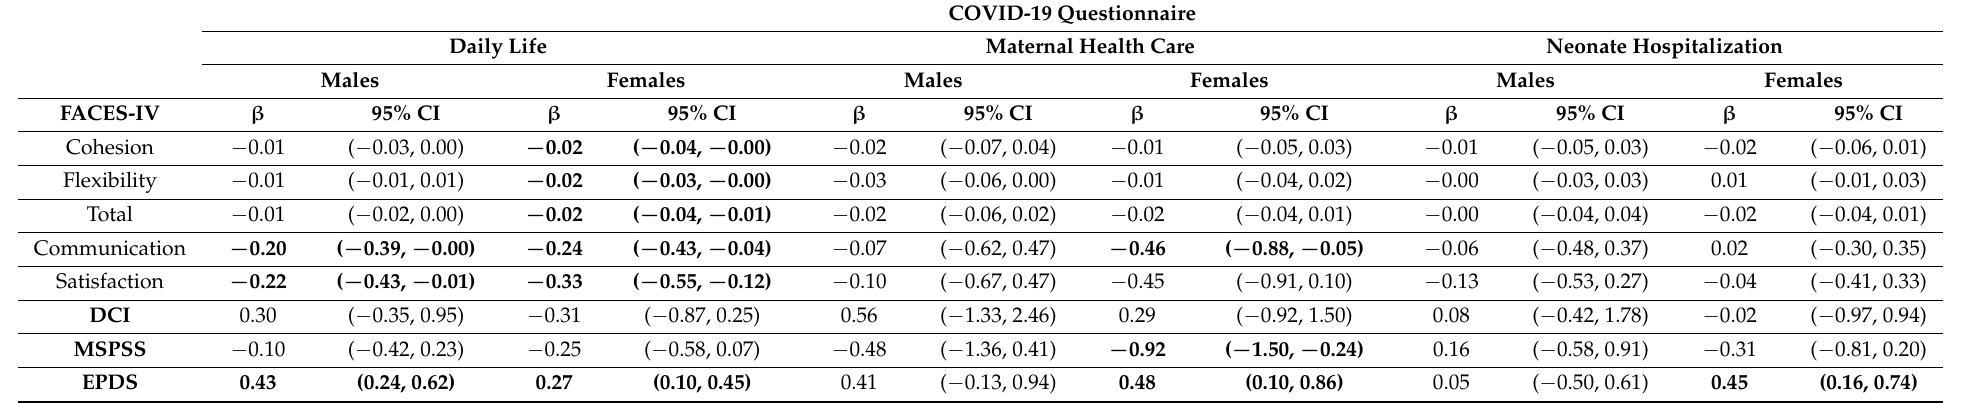
Table 4. Multivariate associations of COVID-19-related life changes with family functioning, dyadic coping, perceived social support and depressive symptoms in